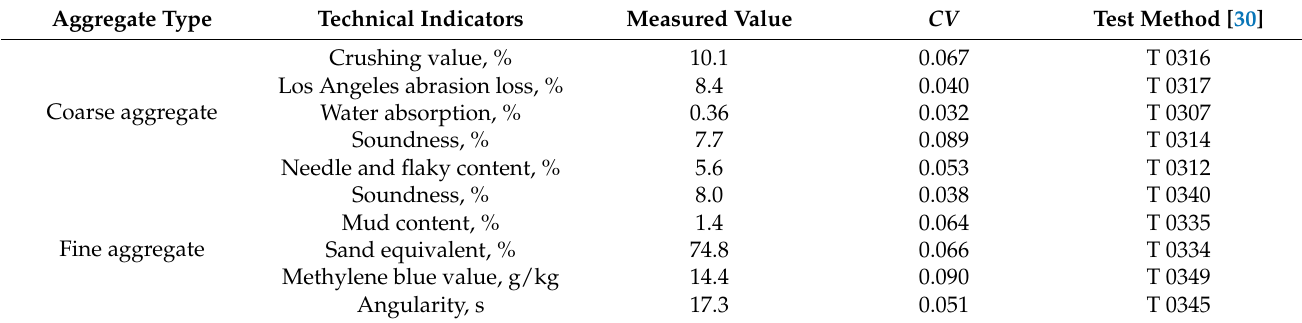
Table 4. Technical indicators of